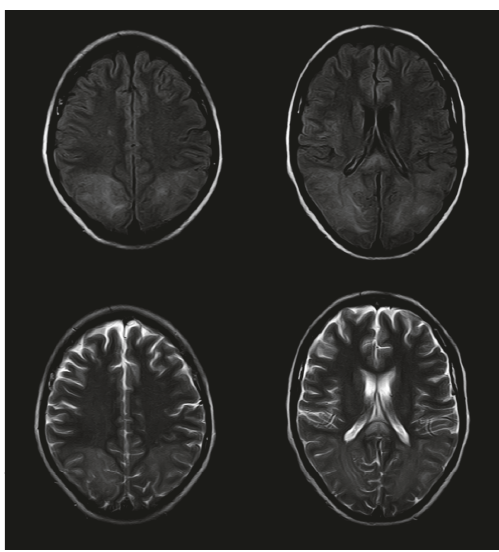
Figure 1: Bilateral symmetrical bright T2 and FLAIR white matter intensity involving the posterior parietal sections of both cerebral hemispheres, as well as the splenial segment of the corpus